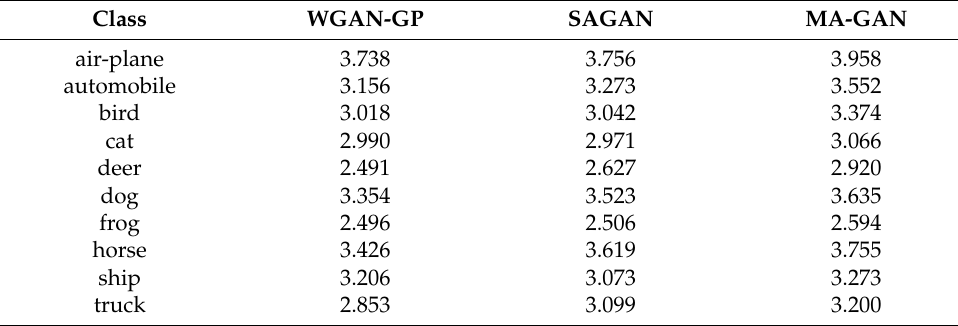
Table 9. The IS of different models on CIFAR-10.